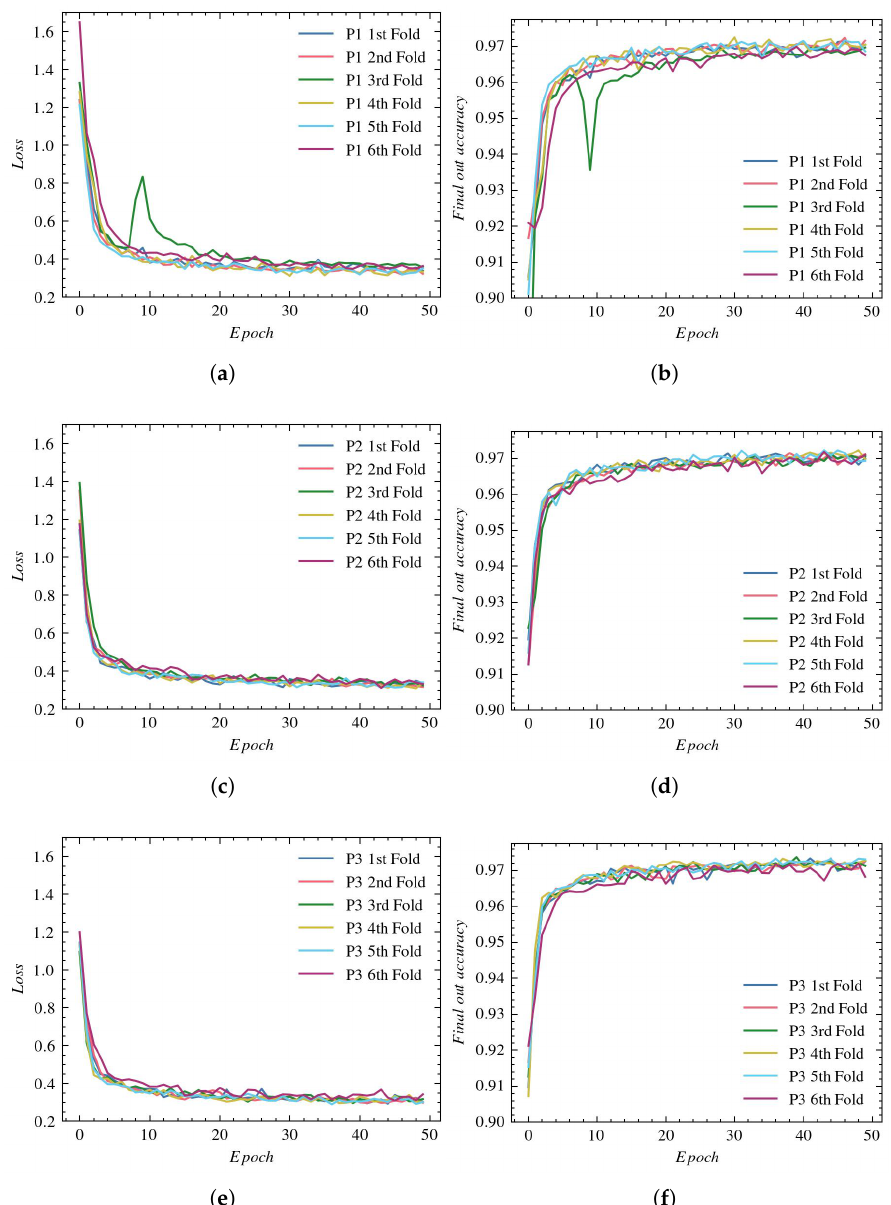
Figure 8. Loss and accuracy plots for IterNet architecture: ( a ) loss using P1, ( b ) accuracy using P1, ( c ) loss using P2, ( d ) accuracy using P2, ( e ) loss using P3, and ( f ) accuracy using